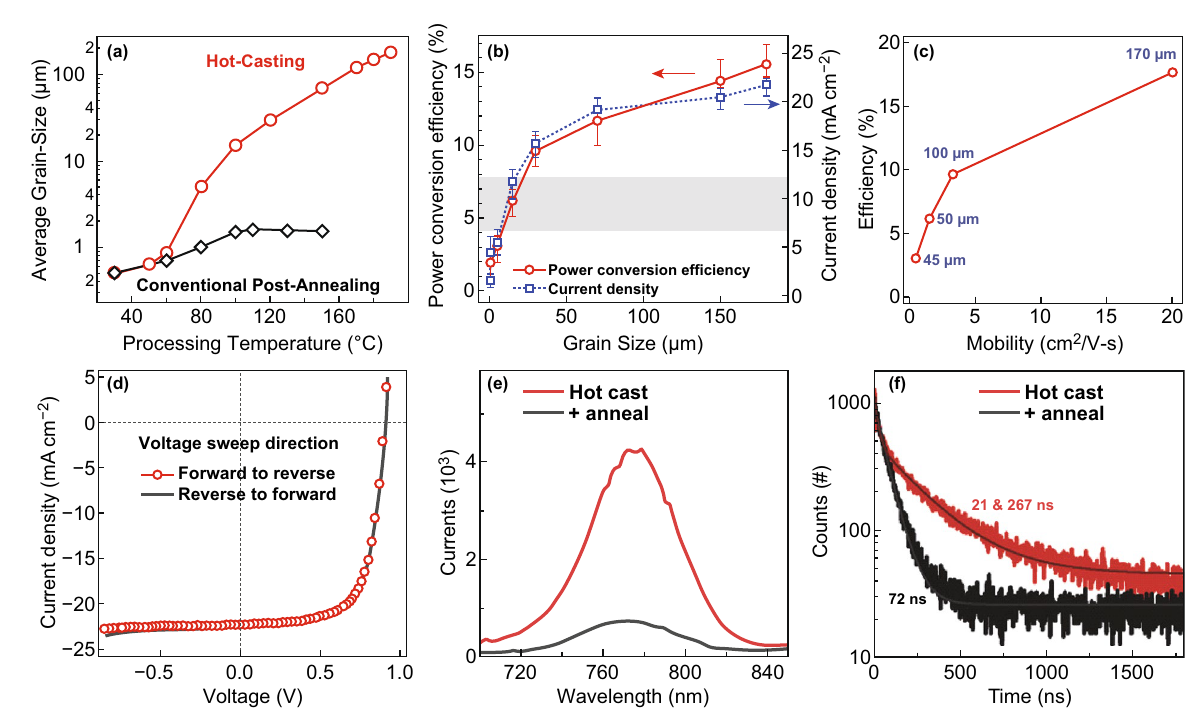
Fig. 2 a Comparison of grain size as a function of the processing temperature. b Average overall PCE (left) and J sc (right) as a function of crys- talline grain size. c PCE values are correlated with the bulk mobility of the perovskite layer (the labels correspond to the average grain size). d Average J – V characteristics resulted by sweeping the voltage from forward to reverse bias and from reverse to forward bias [19]. Copyright © 2017 American Association for the Advancement of Science. e PL and f TRPL spectra of unannealed and annealed perovskites [22]. Copyright © 2016 WILEY-VCH Verlag GmbH & Co. KGaA,